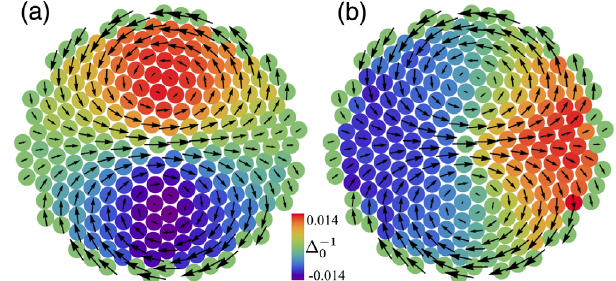
FIG. 11. Cross-sectional projections of infinitely rigid filaments in a sevenfold defective bundle exhibiting the double-vortex tilt pattern. R= Δ 0 ¼ 7 and L=R ¼ 1 . 2 . (a) The double twist, ∂ t − ∂ t x y y x , showing coordinated left- (blue) and right-handed (red) domains. (b) The splay density of the strain variation v ii showing a pattern orthogonal to the double twist, where filament tilt causes a concentration of filaments on the left (blue) and depletion on the right